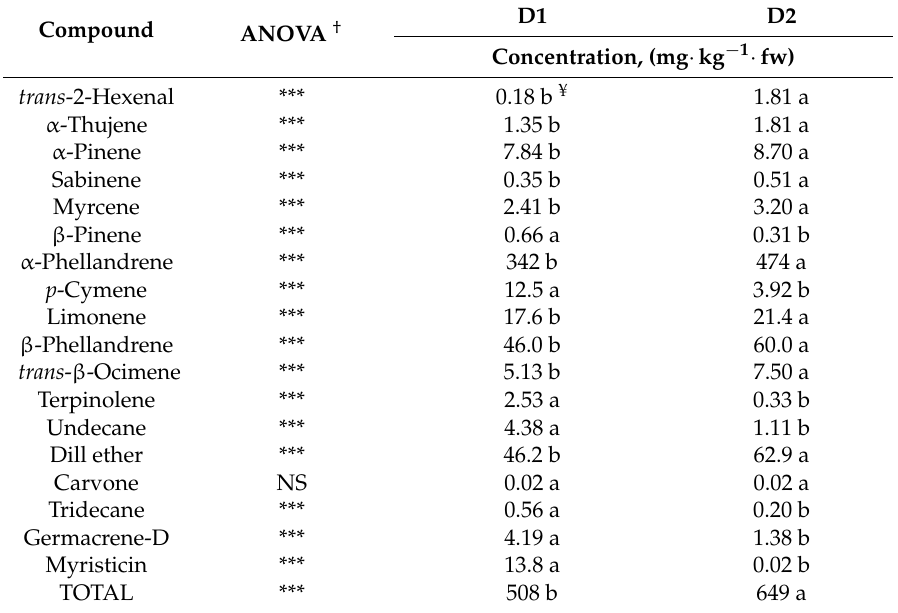
Table 2. Volatile composition of dill essential oil at two commercial stages (mg ¨ kg ´ 1 ¨